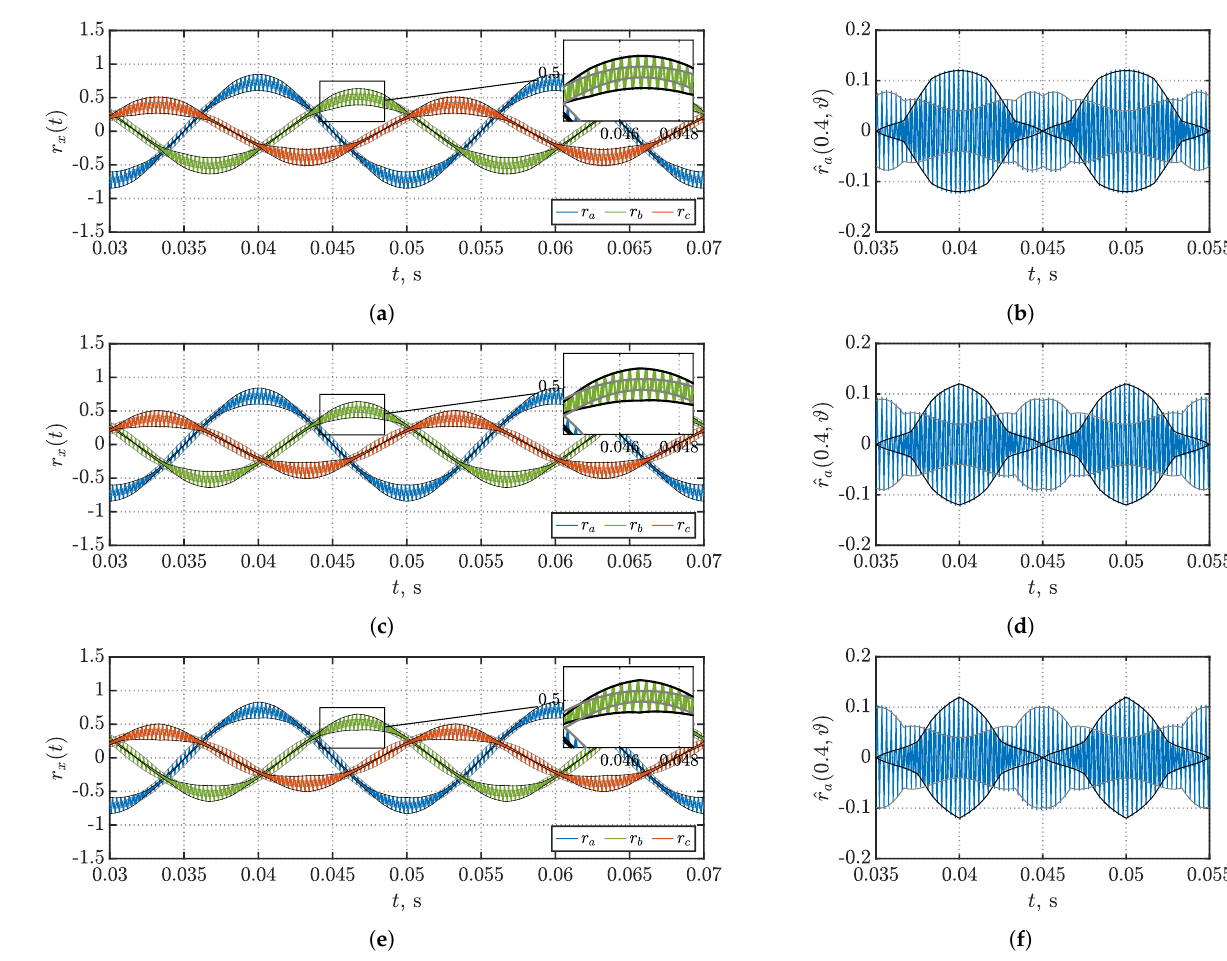
Figure 5. Normalized unbalanced phase currents along with their primary (black) and secondary (gray) current ripple envelopes ( a , c , e ) m = 0.4 and corresponding normalized switching current ripples in phase a with their respective primary (black) and secondary (gray) envelopes and ( b , d , f ) k = 0.5 (upper plots ( a , b )), k = 1 (middle plots ( c , d )), and k = 2 (bottom plots ( e , f )). Table 1. System